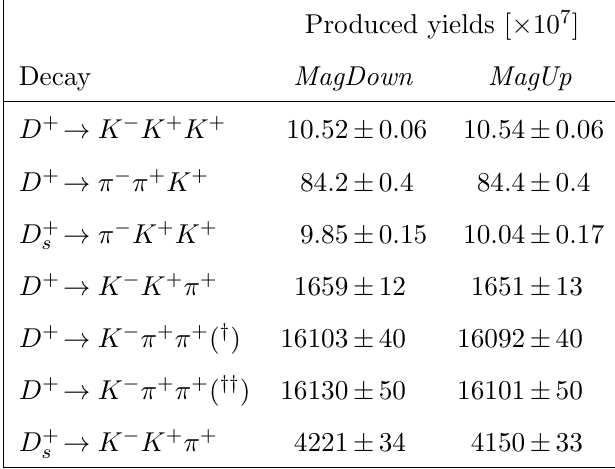
Table 4 . Produced yields for each decay mode with statistical uncertainties, shown separately for MagDown and MagUp samples. The numbers given for the decay D + ! K (cid:0) (cid:25) + (cid:25) +( y ) correspond to the sample with cuts optimised for the D + ! K (cid:0) K + K + and D + ! K (cid:0) K + (cid:25) + and those for the decay D + ! K (cid:0) (cid:25) + (cid:25) +( yy ) to the sample with cuts optimised for the D + ! (cid:25) (cid:0) (cid:25) + K +